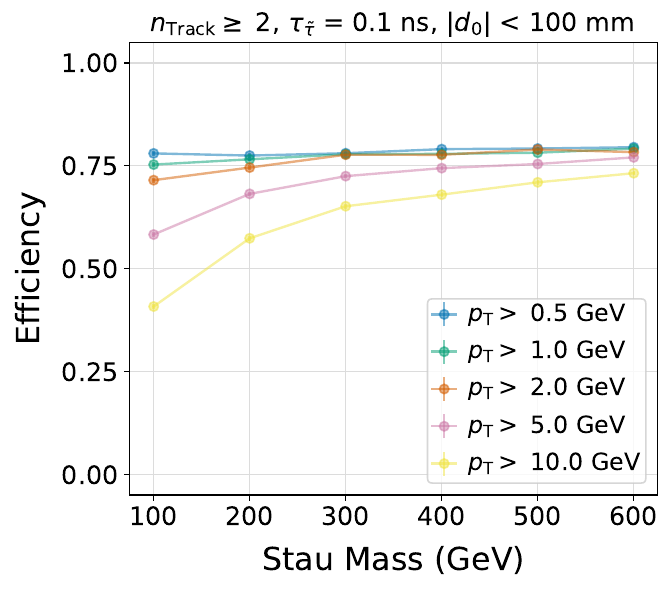
Figure 13. Efficiency as a function of stau mass for a range of minimum track p T values. Events are defined to have passed if they contain two tracks with a p as well as a | d | larger than 1 mm and smaller than 100 mm. The proper lifetime is τ = 0 . 1 ns. Track 0 reconstruction efficiency decreases linearly from 100% for prompt tracks to 0% at | d